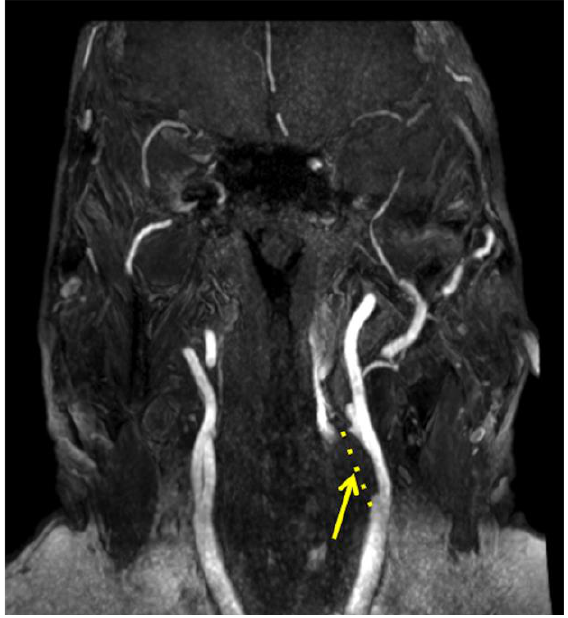
Figure 2. TOF-MRA coronal view shows left partial occlusion of the left common carotid artery at the bulb (arrow) as well as near partial occlusion of the proximal left internal carotid artery (dashed line). Table 1. Advantages and disadvantages of various vascular imaging modalities. Modified from [5]. CTA MRA CDUS